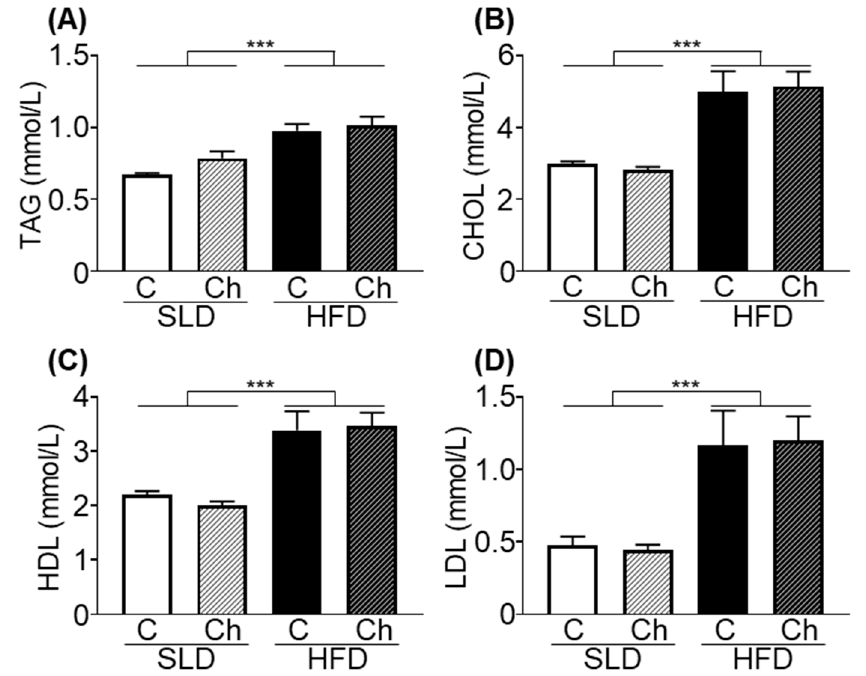
Figure 4. High fat diet (HFD) feeding but not the chronic isoleucine treatment elevated plasma lipid metabolites in mice. Plasma ( A ) total triglycerides (TAG), ( B ) total cholesterol (CHOL), ( C ) high density lipoprotein (HDL), and ( D ) low density lipoprotein (LDL) levels in a standard laboratory diet (SLD) and HFD-mice (SLD / HFD-Control (C) n = 8–10, SLD / HFD-Chronic (Ch) n = 8–10). Values are mean ± SEM *** p < 0.001, diet effect; two-way ANOVA.